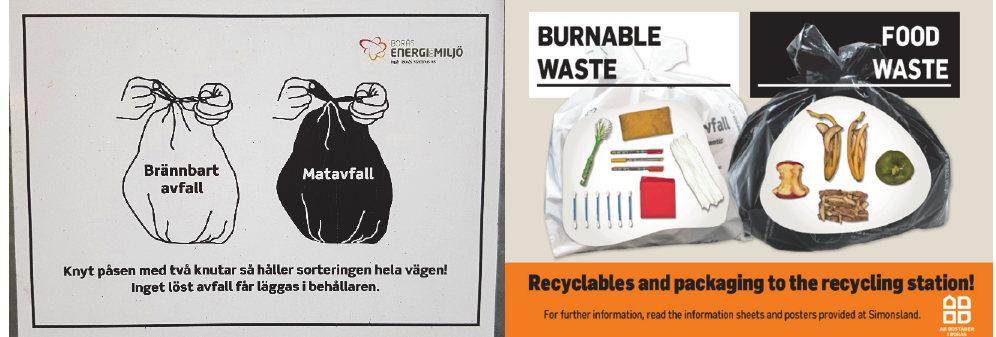
Figure A27. Old (left) and new (right) stickers for the outdoor bins. The text on the white bag in the